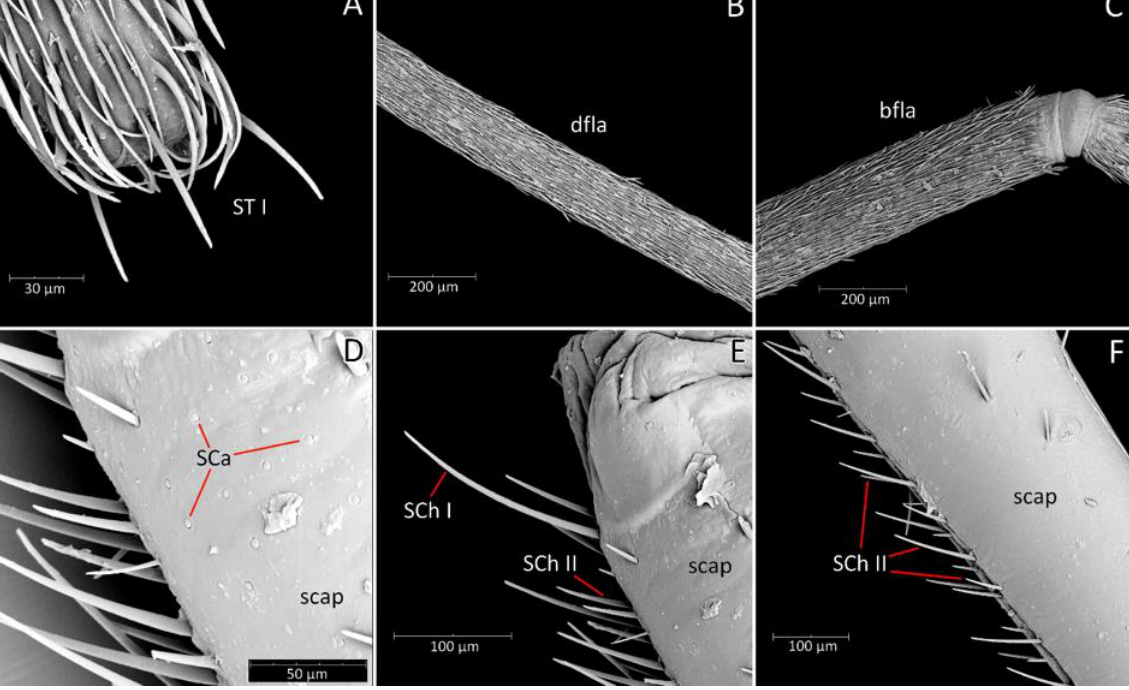
Figure 10. Antennae of Phonoctonus fasciatus (Beauvois, 1805): ( A ) distiflagellomere apex with sensilla trichoidea; ( B ) general view of the distiflagellomere showing the densely arranged sensilla chaetica type II; ( C ) general view of the basiflagellomere with sensilla chaetica type II; ( D – F ) scapus with a different type of sensilla. bfla — basiflagellomere; dfla — distiflagellomere; SCa — sensilla campaniformia; scap — scapus of the antenna; SCh I — sensillum chaeticum type I; SCh II — sensillum chaeticum type II; ST I — sensillum trichoideum type I.